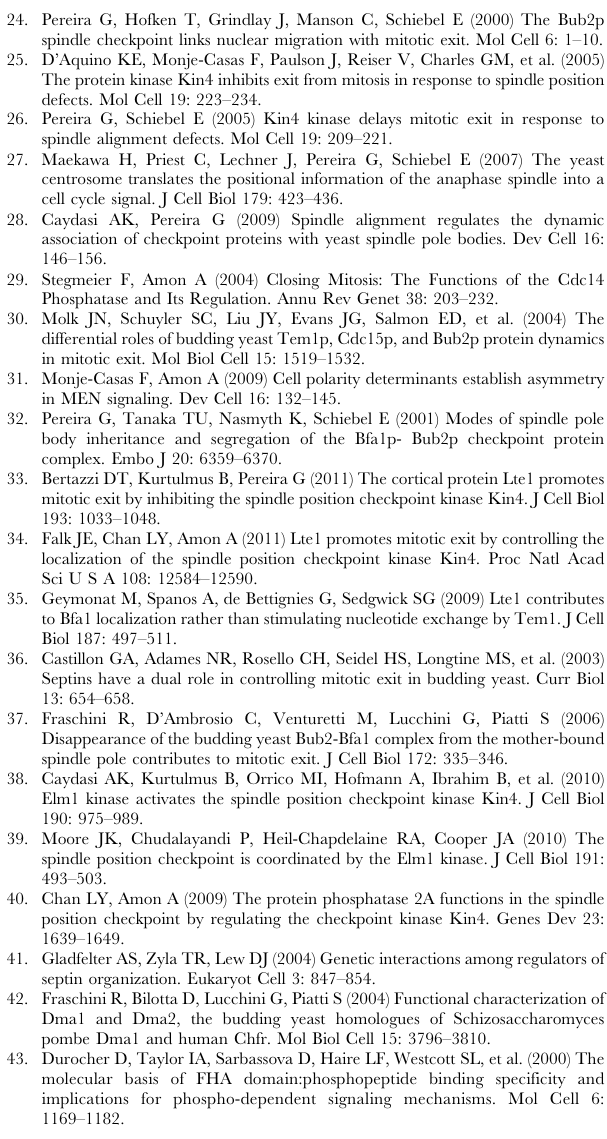
Figure S9 Lack of Dma proteins does neither affect Elm1 kinase activity nor Kin4 and Rts1 protein levels. A: Elm1-HA3 was immunoprecipitated with anti-HA antibodies from cell extracts of wild type (ySP8820) and dma1 D dma2 D (ySP8821) cells, either cycling (cyc) or arrested in the cell cycle by HU or nocodazole (noc) addition. Wild type cells expressing untagged Elm1 (W303) were used as negative control. A fraction of the total extracts used for the immunoprecipitations (input) was analysed by western blot with anti-HA and anti-Pgk1 (loading control) antibodies. Elm1 kinase assays were carried out for 30 9 at 30 u C to detect Elm1 autophosphorylation. An asterisk indicates an aspecific band appearing in the kinase assays. B: Cycling cultures of wild type (ySP8986 and ySP9133) and dma1 D dma2 D (ySP8987 and ySP9127) cells expressing either Kin4-HA3 or Rts1-HA3 were split in three: one aliquot was left untreated (cyc), one was treated with 150 mM HU and one with 15 m g/ml of nocodazole (noc) for 3 hours at 25 u C. Crude protein extracts were analysed by western blot with anti-HA and anti-Pgk1 (loading control) antibodies. (TIF)